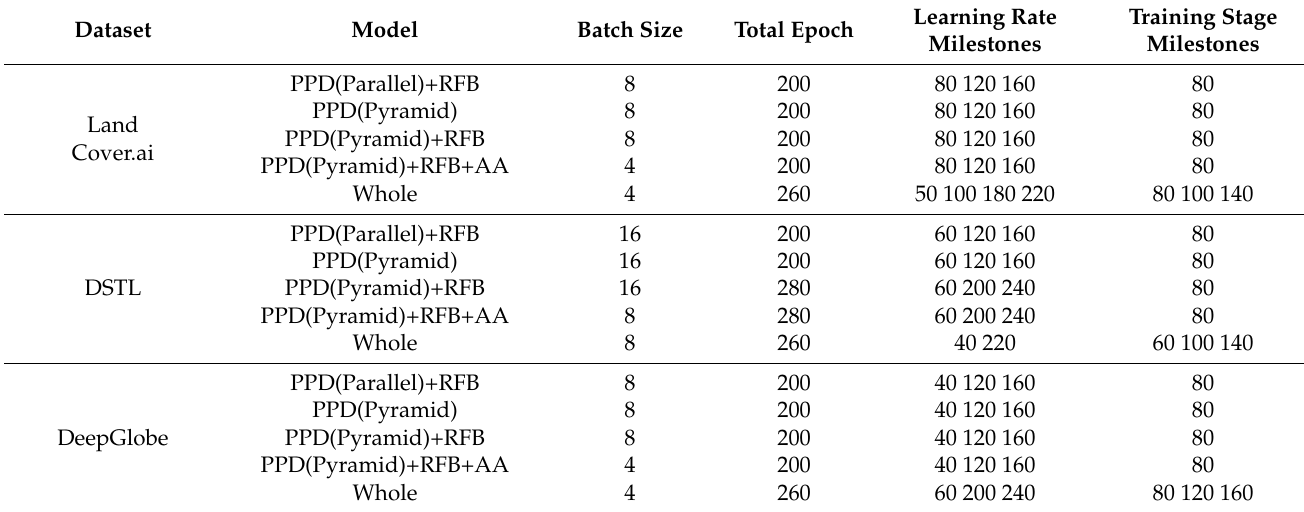
Table 4. Training hyperparameters for each model in ablation study of architecture on the three datasets. Dataset